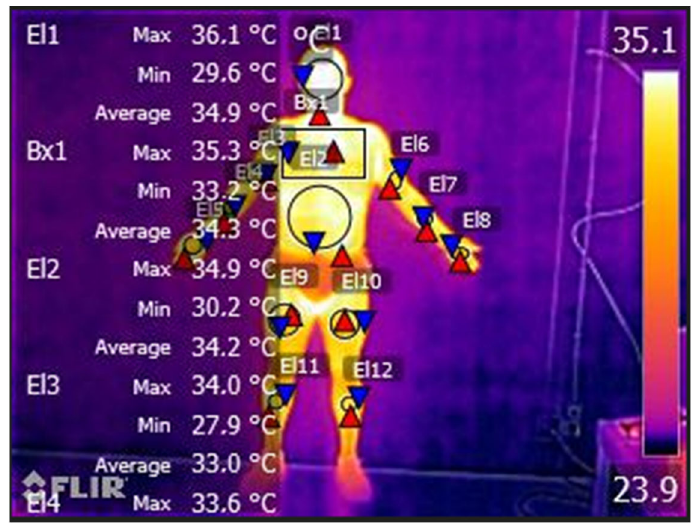
Figure 3. Temperature modification (°C) evaluated by thermography in Heart Attack Patients (HAP) and control participants in pre- and post- treadmill protocols (HIIT vs. MICT).